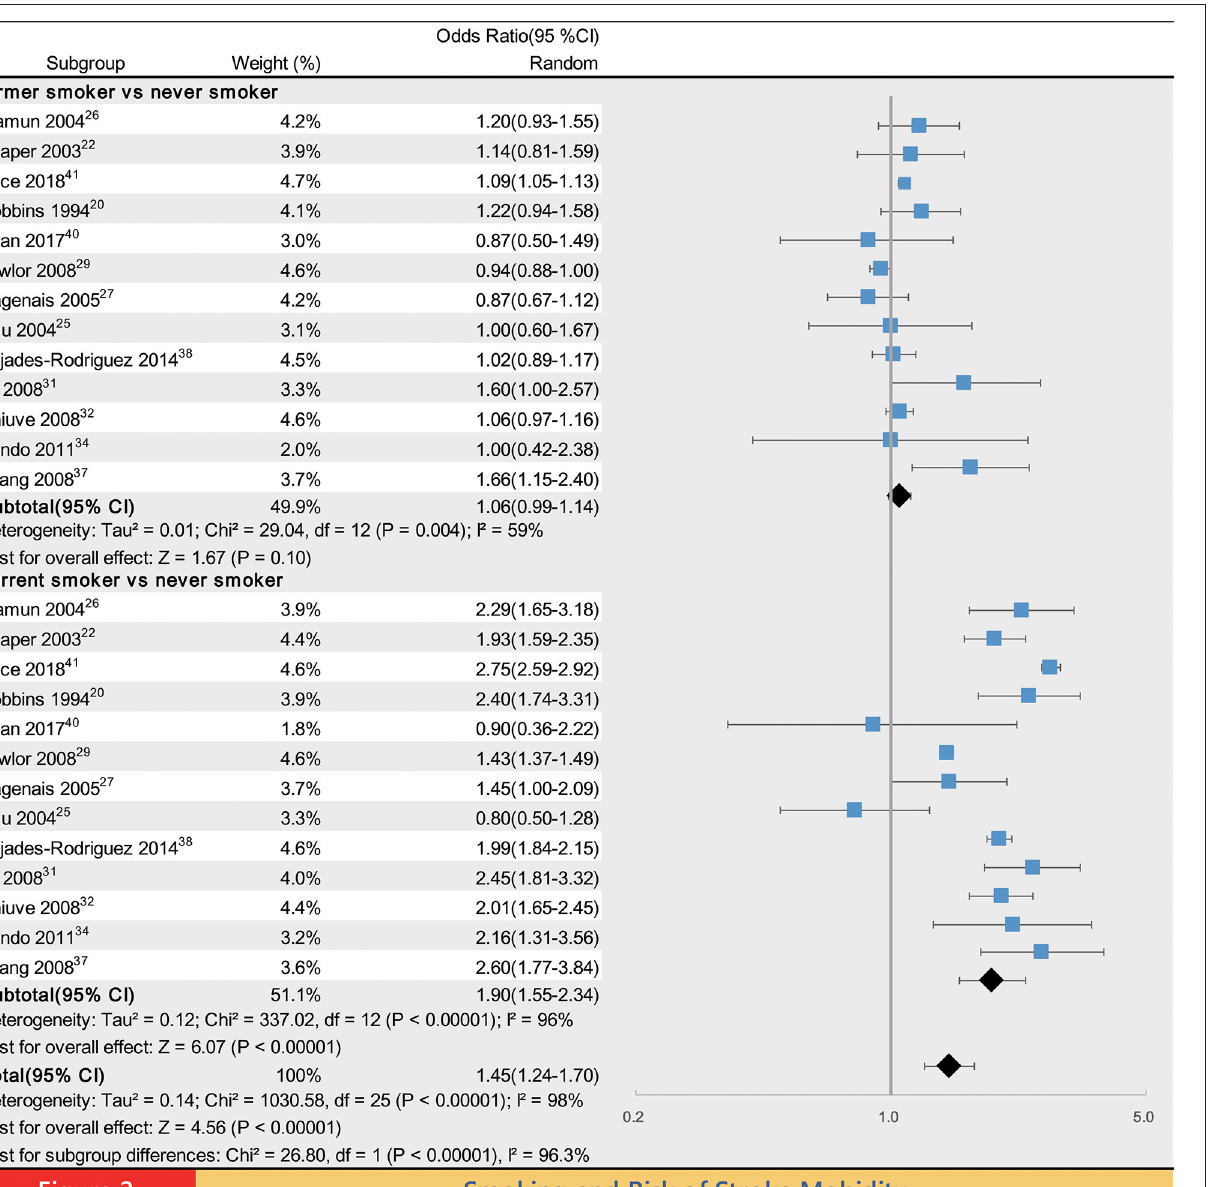
FIGURE 2 | Forest plot of the primary outcome. CL, confidence interval.